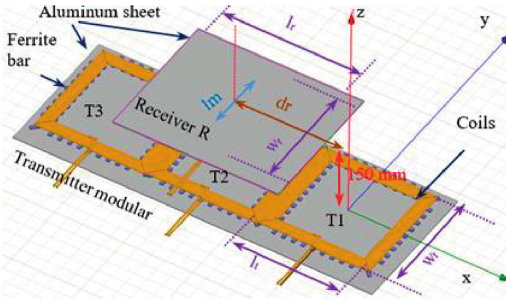
Figure 2: Magnetic coupler structure.